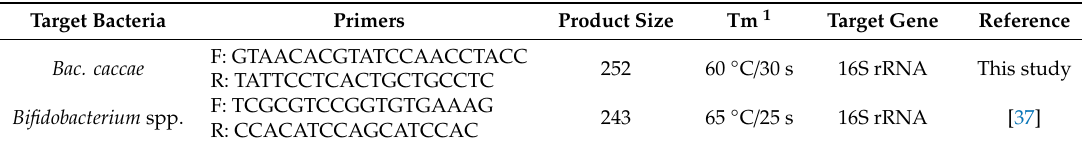
Table 1. Genus-specific primers used for quantification by droplet digital PCR (ddPCR).